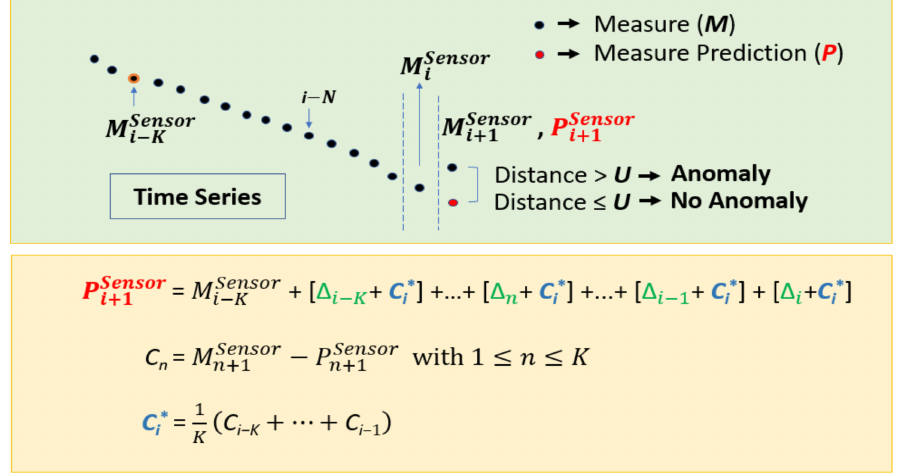
Figure 5. NADCA-L: Generalization of NADCA-B for anomaly detection and correction in signals without